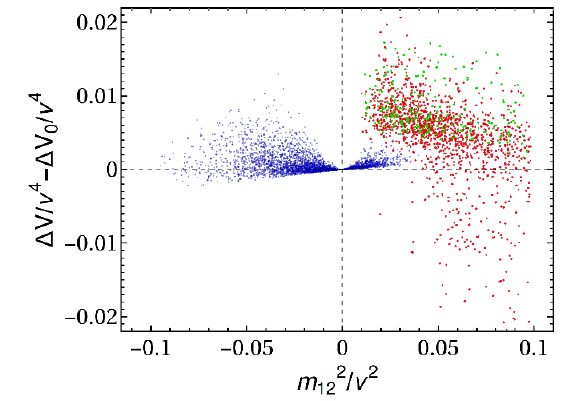
Figure 8 . One-loop correction to the potential di(cid:11)erence relative to the tree level potential di(cid:11)er- ence. The color coding follows (cid:12)gure